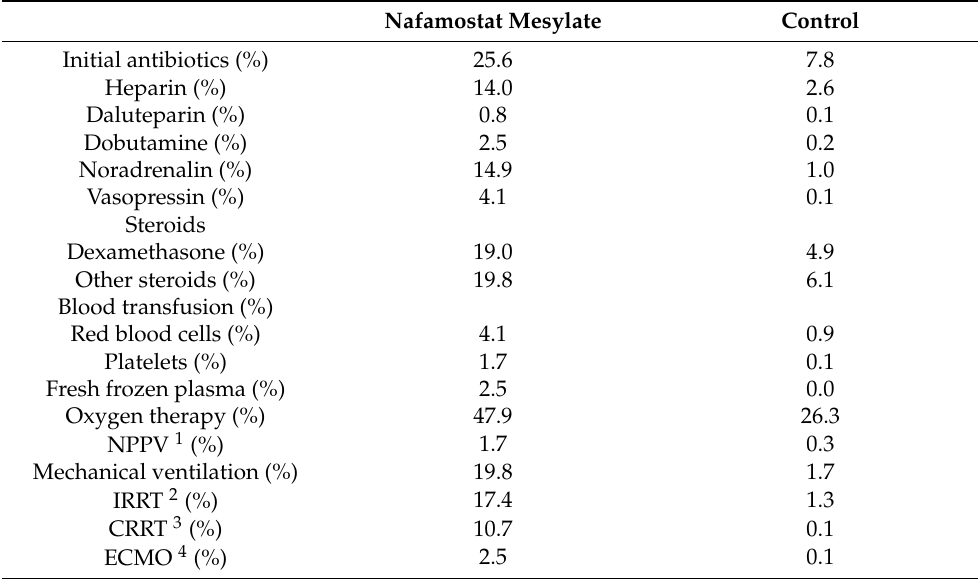
Table 2. Treatment within 2 days of admission in the unmatched cohort. Nafamostat Mesylate